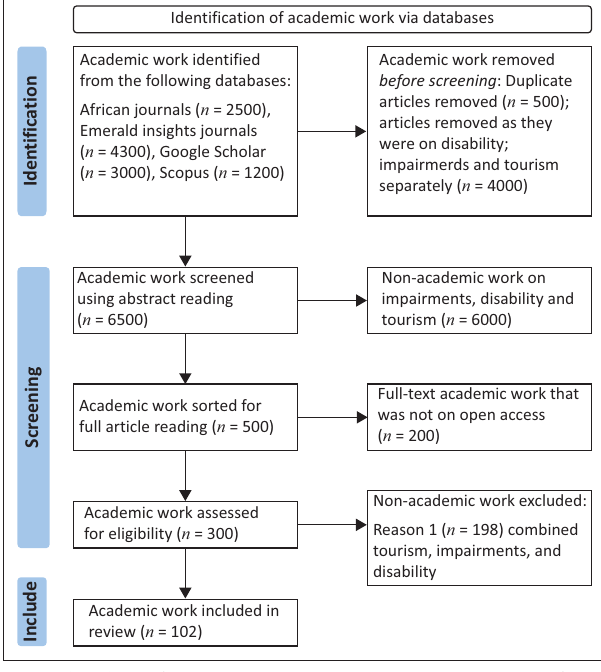
FIGURE 2: Summary of data collection, screening and analysis